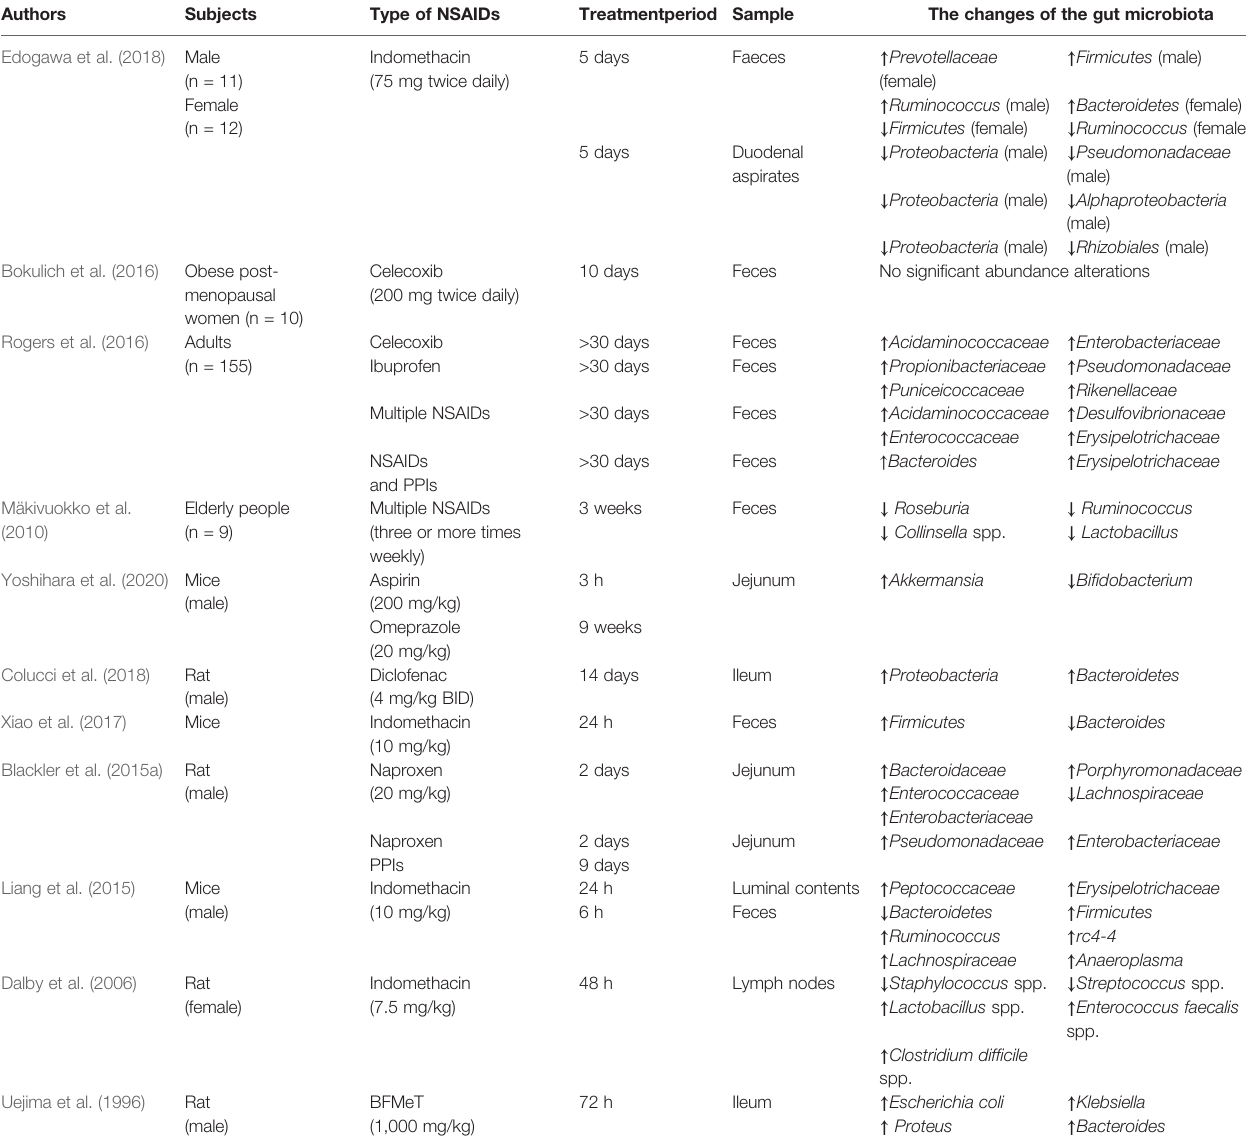
TABLE 1 | The changes of the gut microbiota in subjects receiving